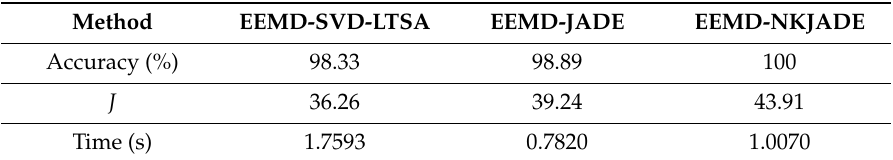
Table 2. Results from dataset A.